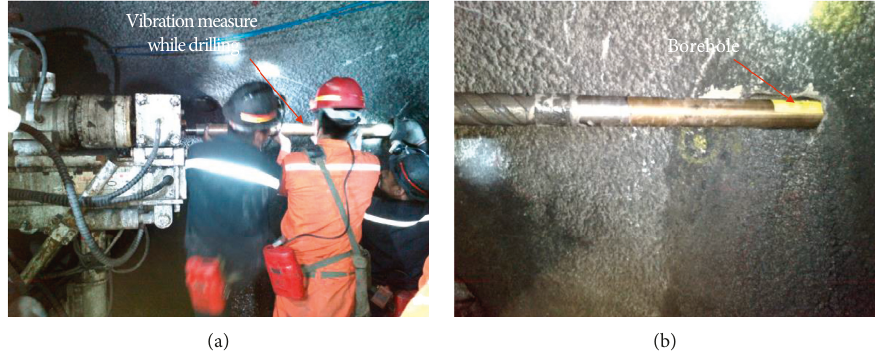
Figure 12: Field installation of the VMWD system.